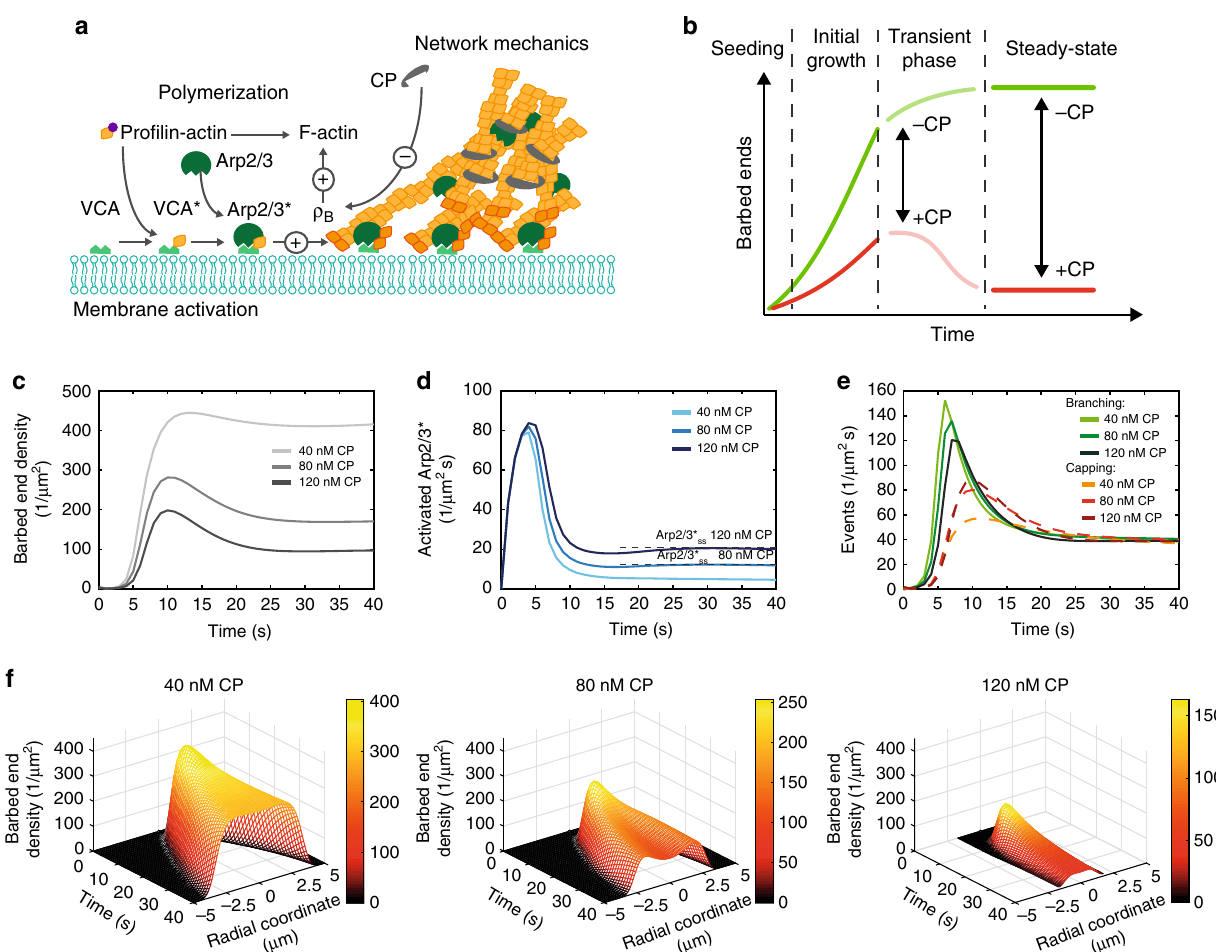
Fig. 5 Localized actin polymerization is modelled in the presence of CP. a Schematic of membrane localized actin assembly kinetics: a fi nite reservoir of membrane activated Arp2/3 complex nucleates a branched network at the membrane. After polymerization start the available Arp2/3 complex reservoir must equilibrate towards a new steady-state concentration as the regeneration rate is slow. The balance between branching by Arp2/3 complex and capping by CP determines the fi nal network mechanics leading two the observed shape deformations of the membrane. b Network growth can be observed by modelling the temporal evolution of barbed ends. Four different growth regimes occur. The seeding phase, where fi rst barbed ends are formed, is followed by an initial rapid growth. Finally the barbed ends level off to a steady-state by passing a transient phase. The growth processes depend on the concentration of CP. c – e The temporal evolution of barbed ends ( c ), activated Arp2/3 complex (Arp2/3*) ( d ), branching and capping events ( e ) at in fi nite protein pools is shown. The fi nal steady-state of barbed end density and Arp2/3* was set by CP concentration. The balance between branching and capping events controlled the equilibration process of network growth towards the steady state. f The spatio-temporal network growth was modelled along the membrane at fi nite protein pools. Two distinct barbed end patterns emerged. At 40 and 120 nM CP a fl at barbed end distribution was observed and at 80 nM a double-peaked density distribution